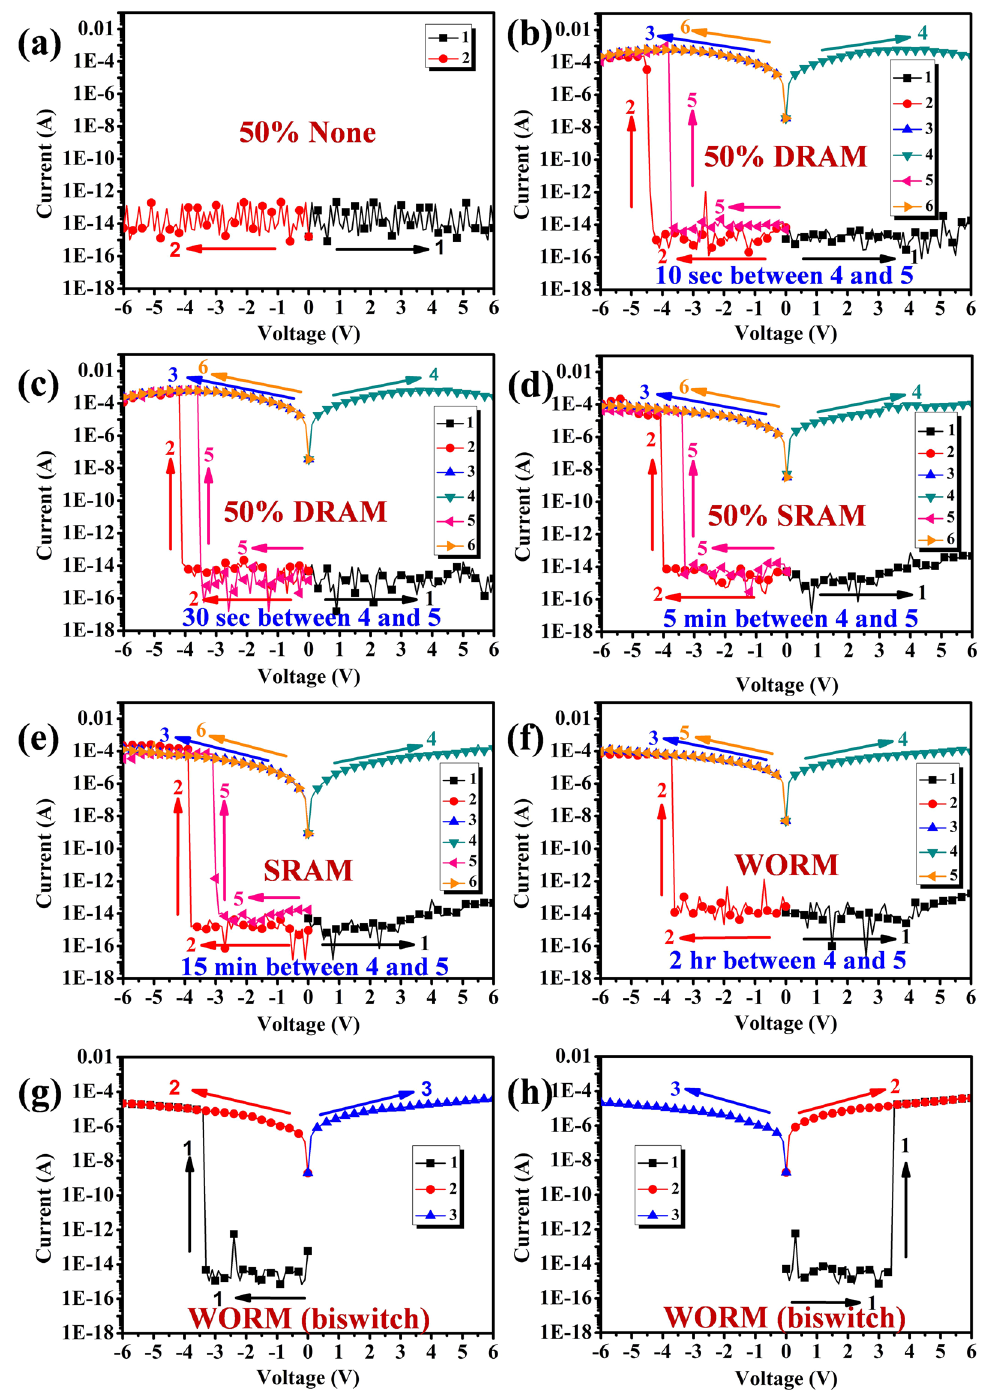
Figure 5. Current-voltage (I–V) features of the ITO/S-OH/TiO 2 materials of hybrids (50 ± 3 nm)/Aluminum memory device. ( a ) and ( b ) S-OHTi5. ( c ) and ( d ) S-OHTi7. ( e ) S-OHTi10. ( f ) S-OHTi15. ( g ) and ( h )